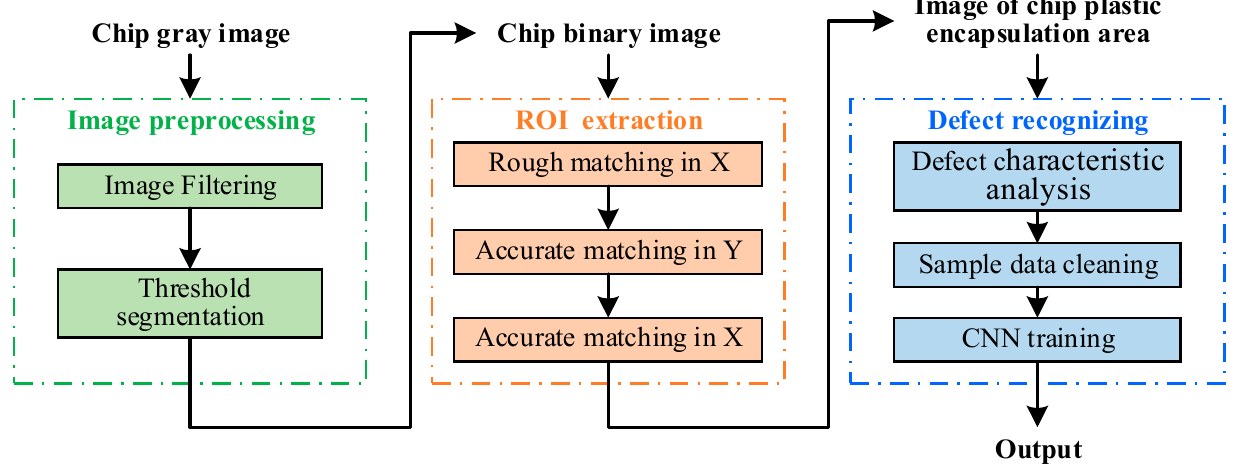
Figure 2. Overall scheme of chip surface defect-detection algorithm.